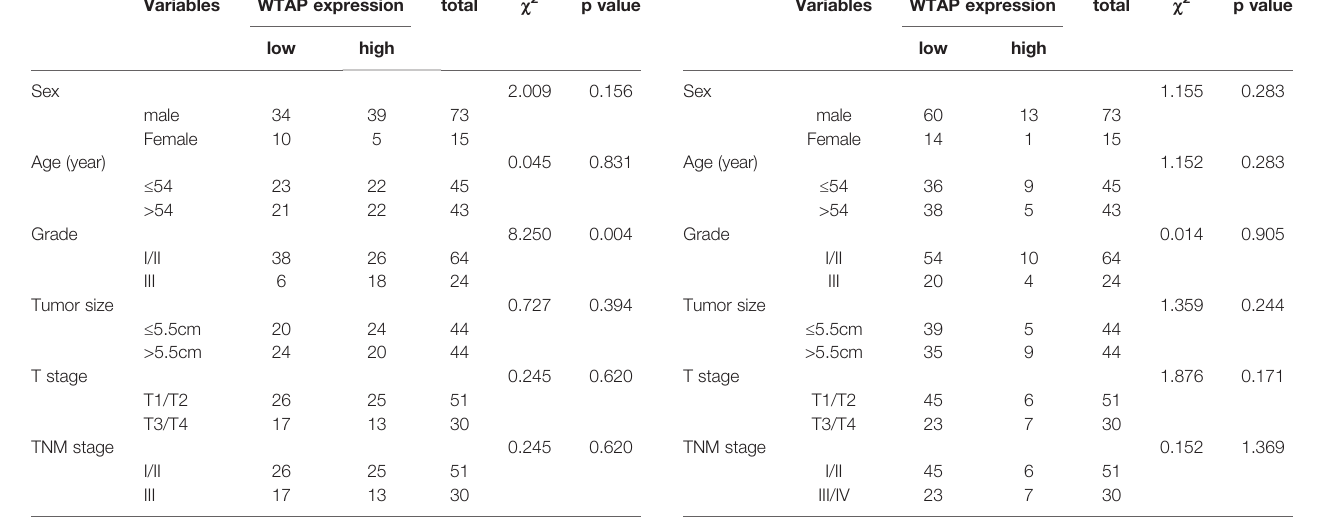
TABLE 2 | Relationship between WTAP expression levels in the nucleus and clinicopathological characteristics in HCC patients. Variables